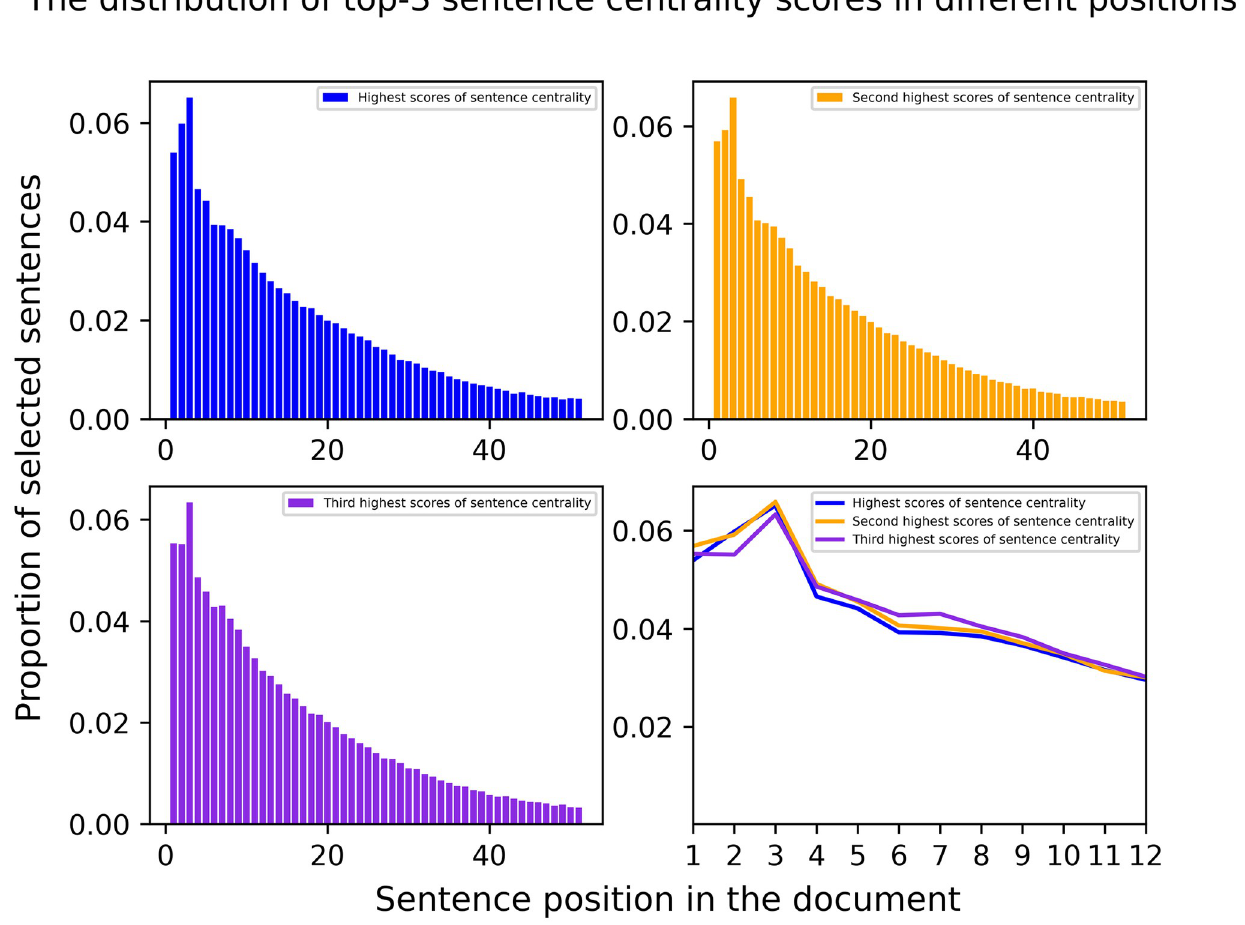
Fig 4. The distribution of top-3 sentence centrality scores in different positions. Sentences with high centrality scores tend to be located in front of the document.